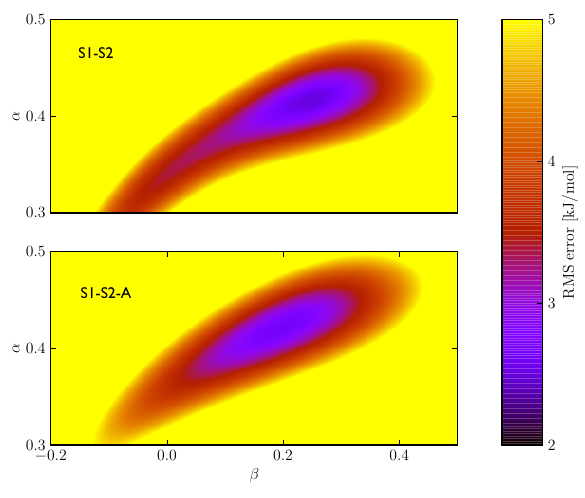
Figure 3. 3D contour plots of the dependency of the RMSE (root-mean square error between calculated and experimental binding free energies) on α and β values for the S1–S2 ( a ) and S1-S2-A ( b ) LIE models, which are based on inclusion of results from all MD simulations. The color bar indicates a range of RMSE values between 2 and 5 kJ mol − 1 . RMSE values of 5 kJ mol − 1 and higher are depicted in yellow.